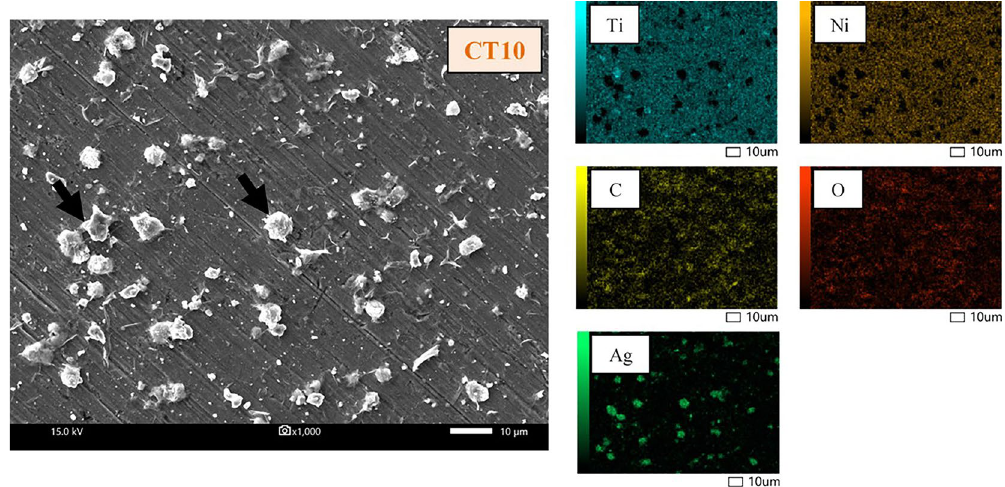
Figure 3. SEM images and EDS mapping of the 10 min GO/AgNPs coated NiTi alloy sample (CT10). Black arrows indicate the GO assembly with the AgNPs.